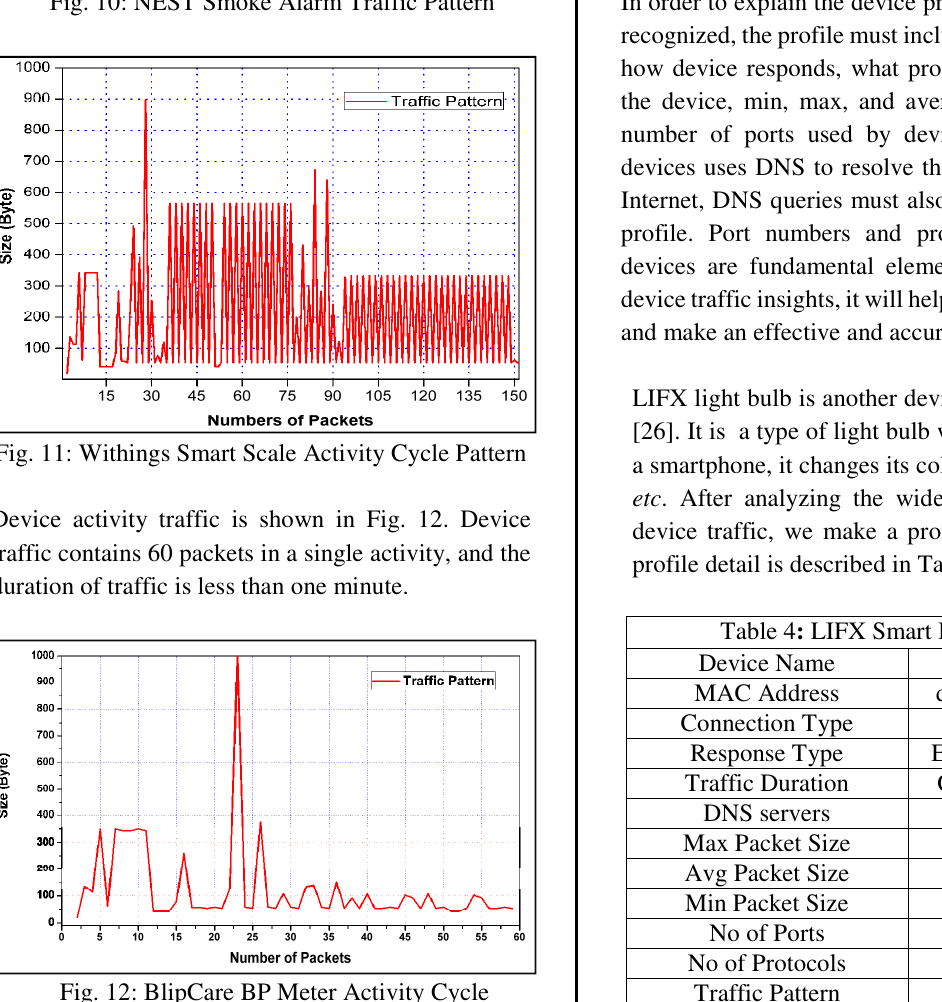
Fig. 12: BlipCare BP Meter Activity Cycle